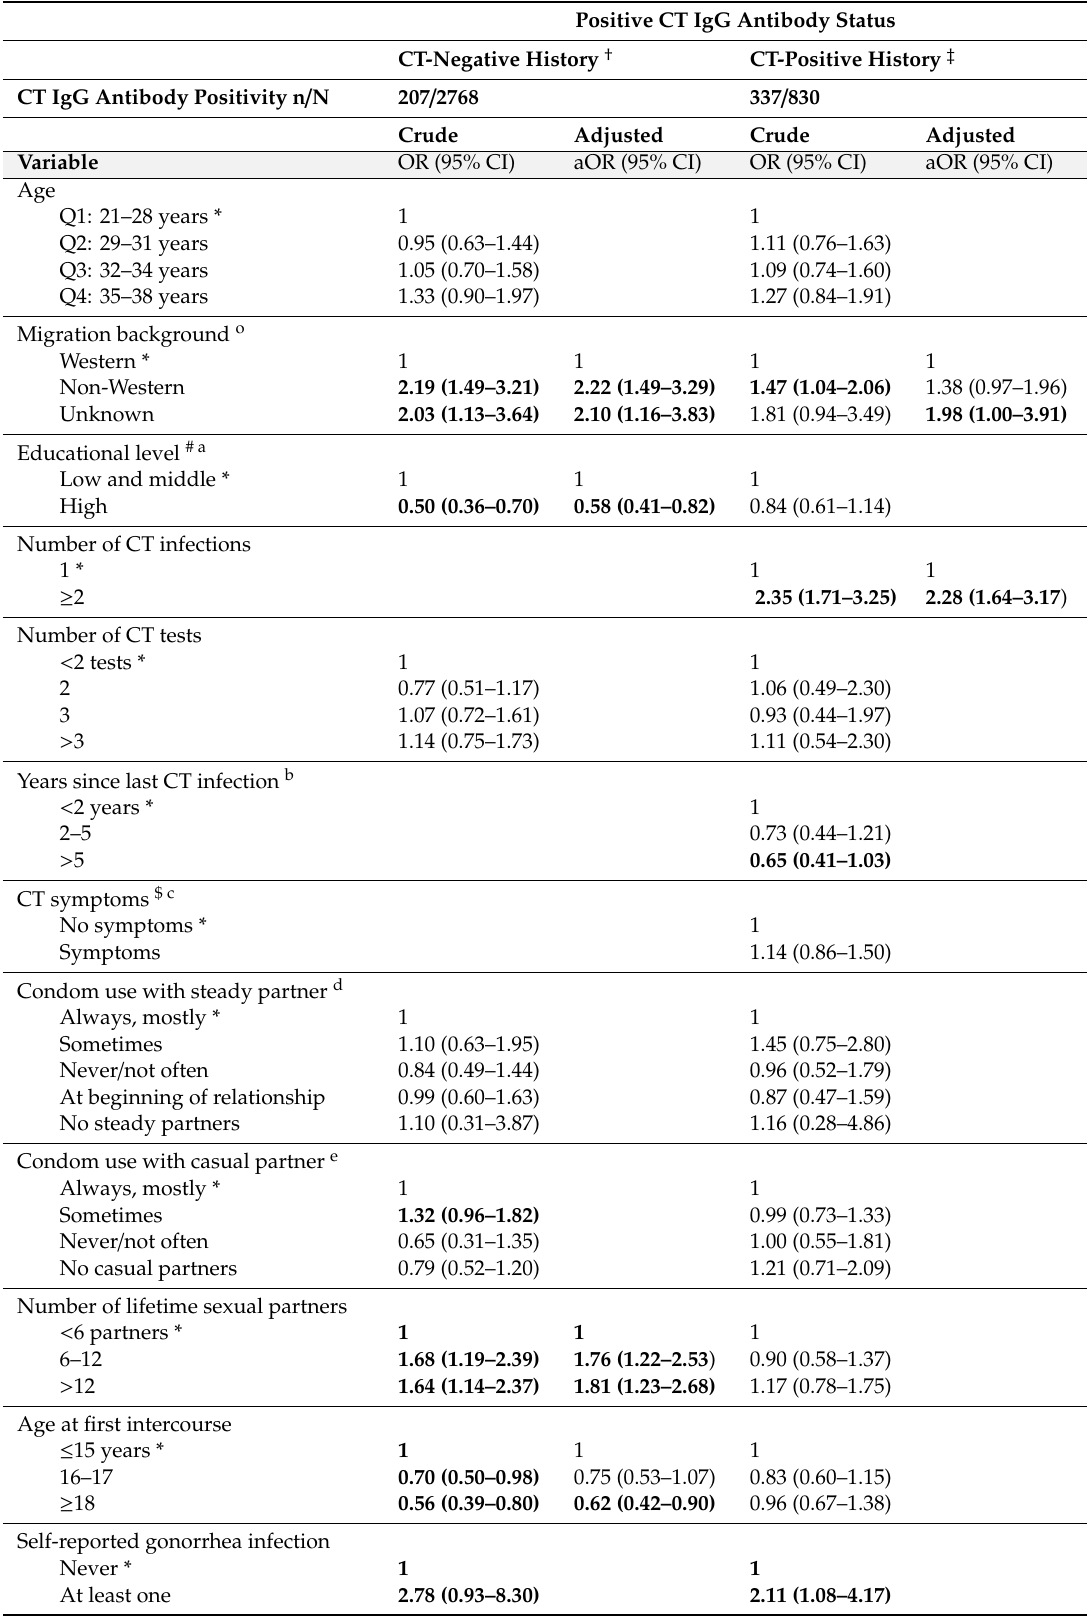
Table 3. Univariable and multivariable analyses of Chlamydia trachomatis (CT) IgG antibody status stratified for women with a CT-negative and a CT-positive